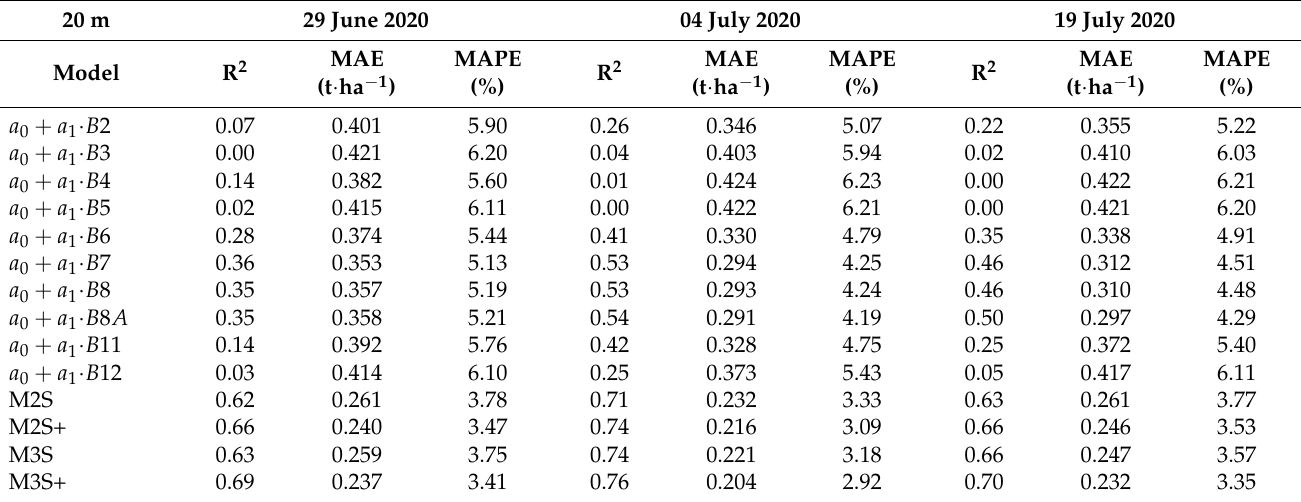
Table A2. JSendra 20 m spatial resolution model evaluation with training data (model coefficients are different for each equation).